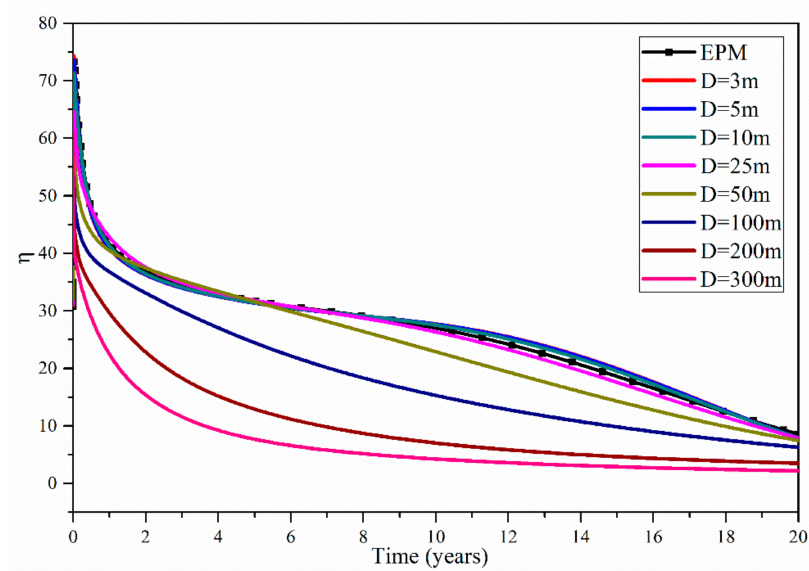
Figure 9. Evolution of the energy efficiency of the EPM method and the MINC